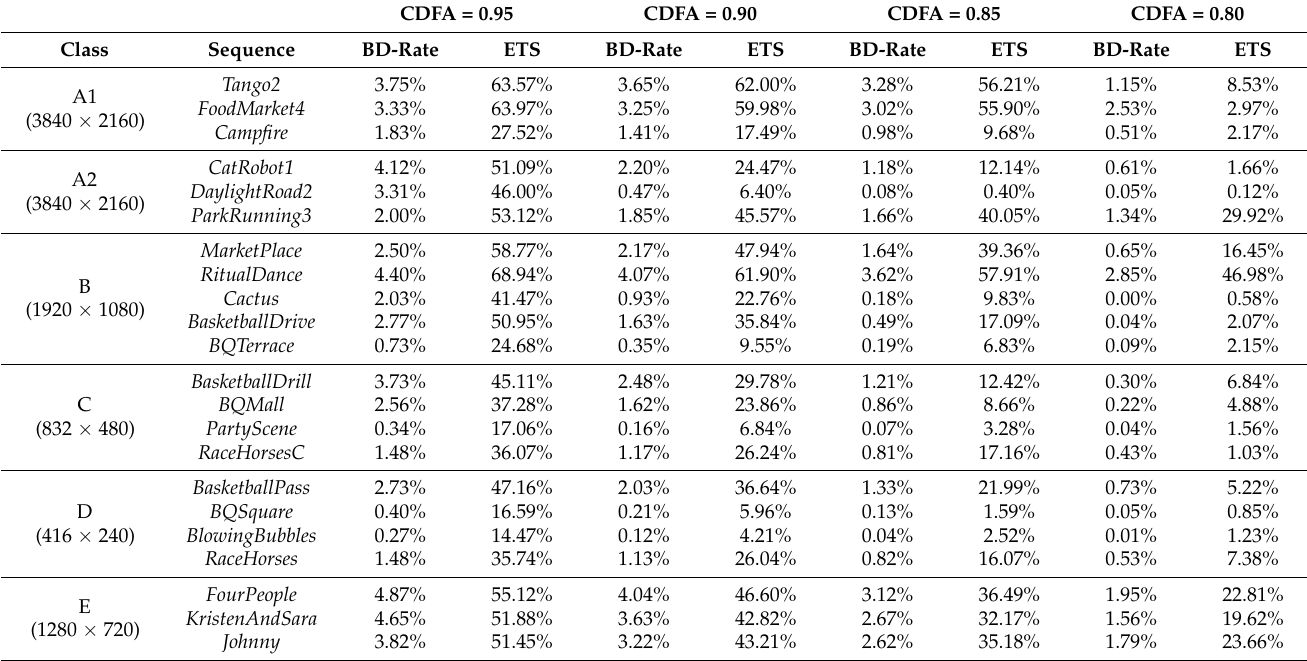
Table 4. Performance of proposed method with directionality on VTM